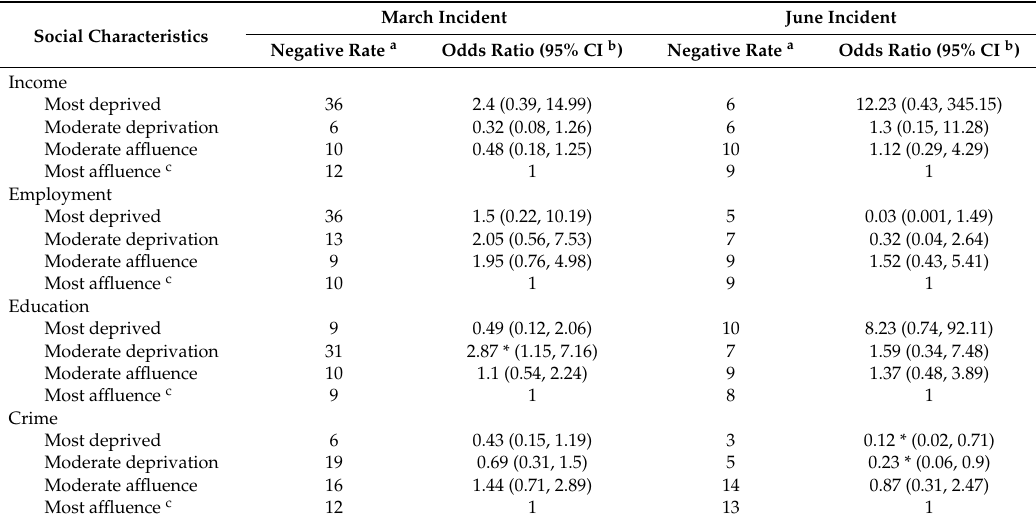
Table 4. The risk of negative emotions in relation to social